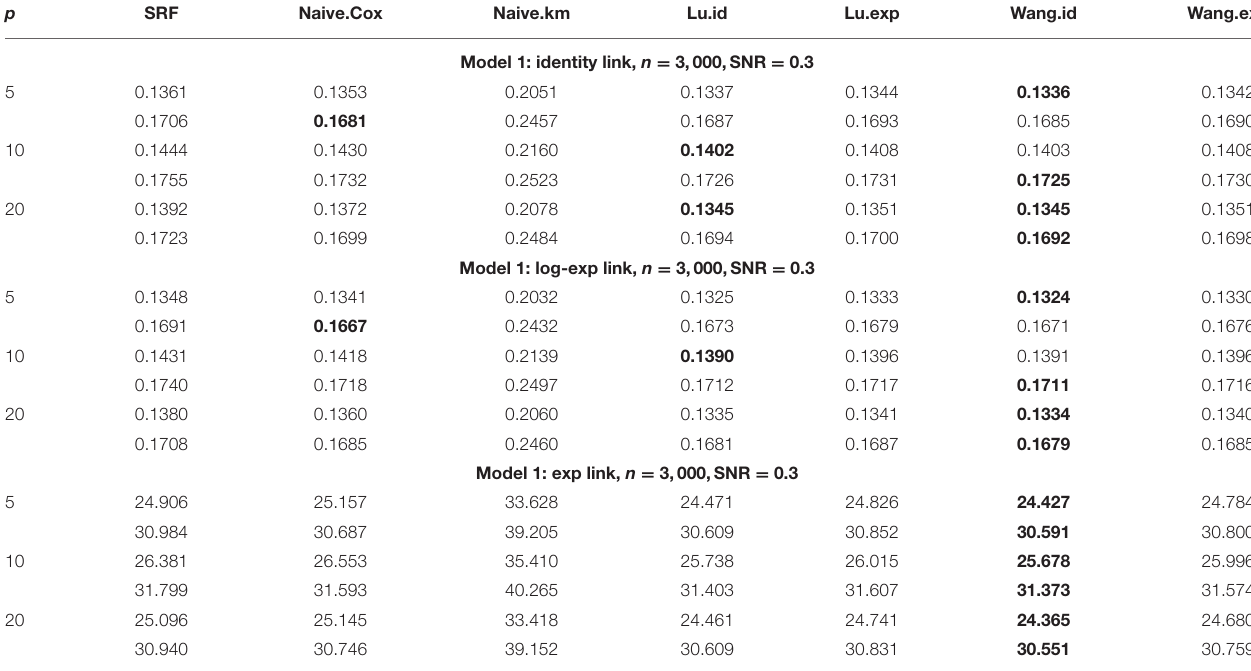
TABLE 3 | Comparison of Mean-Absolute-Error (MAE) and Rooted-Mean-Squared-Error (RMSE) for Model 1 with different link functions and the censoring distribution is mis-specified with α =